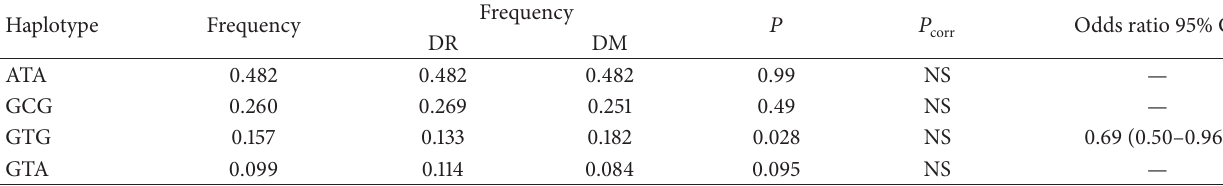
Table 3: Haplotype analysis of CFB Polymorphisms between DR and